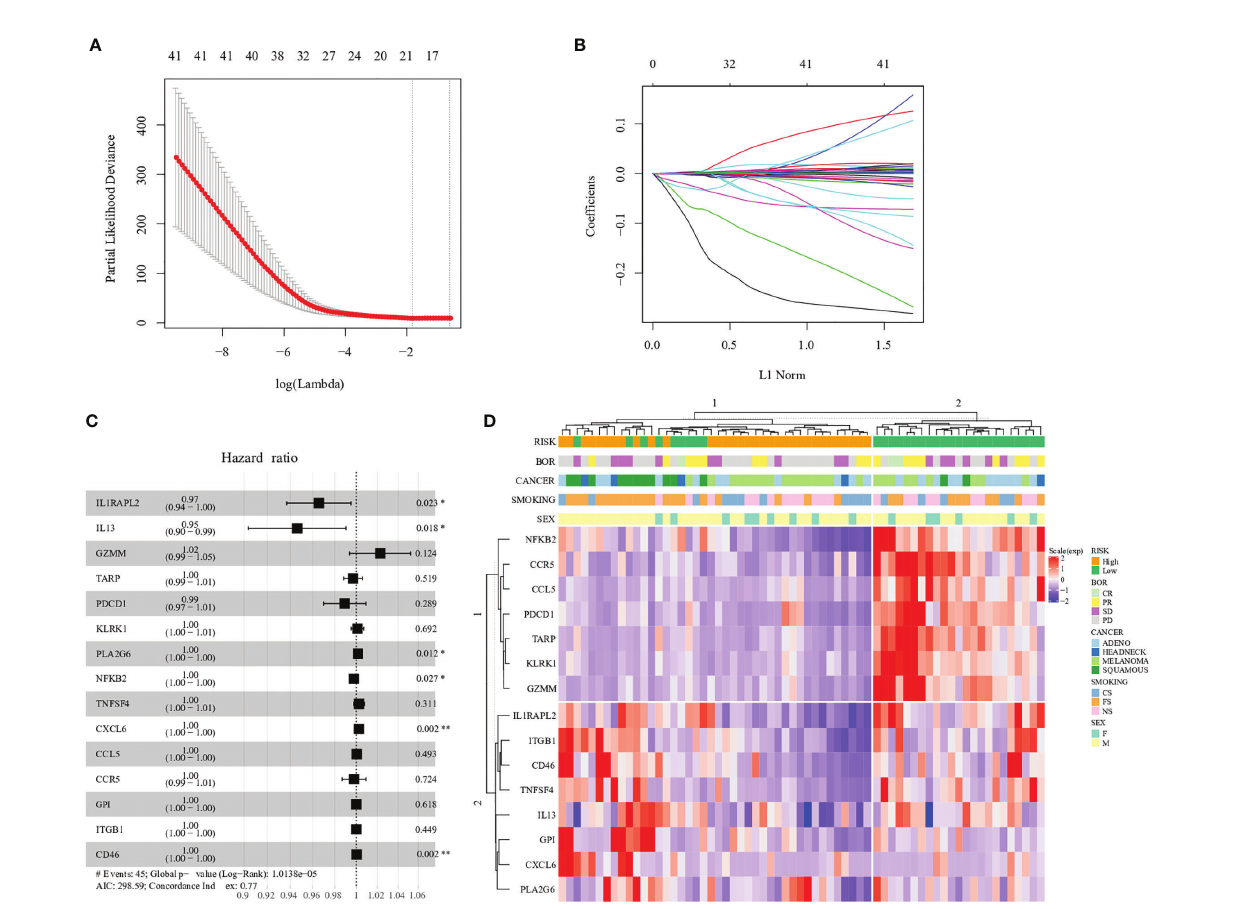
FIGURE 1 | Construction of the immune − related gene model in the prognosis of immunotherapy. (A) 1000 bootstrap replicates by lasso Cox regression analysis for variable selection. (B) LASSO coef fi cients of prognosis genes. Each curve represents a prognosis gene. (C) Multivariate Cox proportional-hazards model of 15 immune-related genes based on Prat cohort. Forest plot of 15 immune-related genes and their association with clinical survival, with hazard ratio values shown on the y-axis, and p-values derived from multivariate CoxPH analysis. (D) Hierarchal clustering analysis of 15 immune-related genes in the Prat cohort. '*',P < 0.05. '**', P <